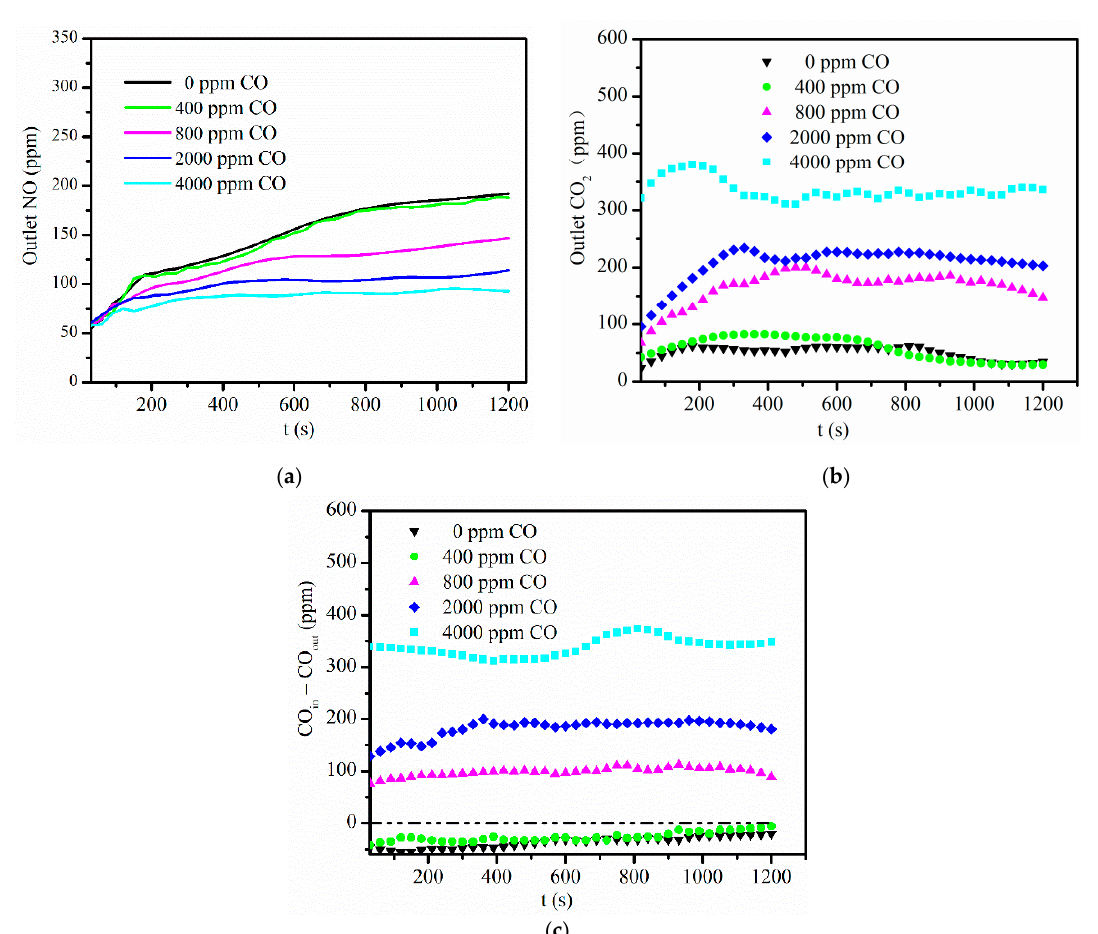
Figure 2. Influence of CO on the evolution of ( a ) outlet NO concentration and the amounts of ( b ) CO 2 formed and ( c ) CO consumed with time.